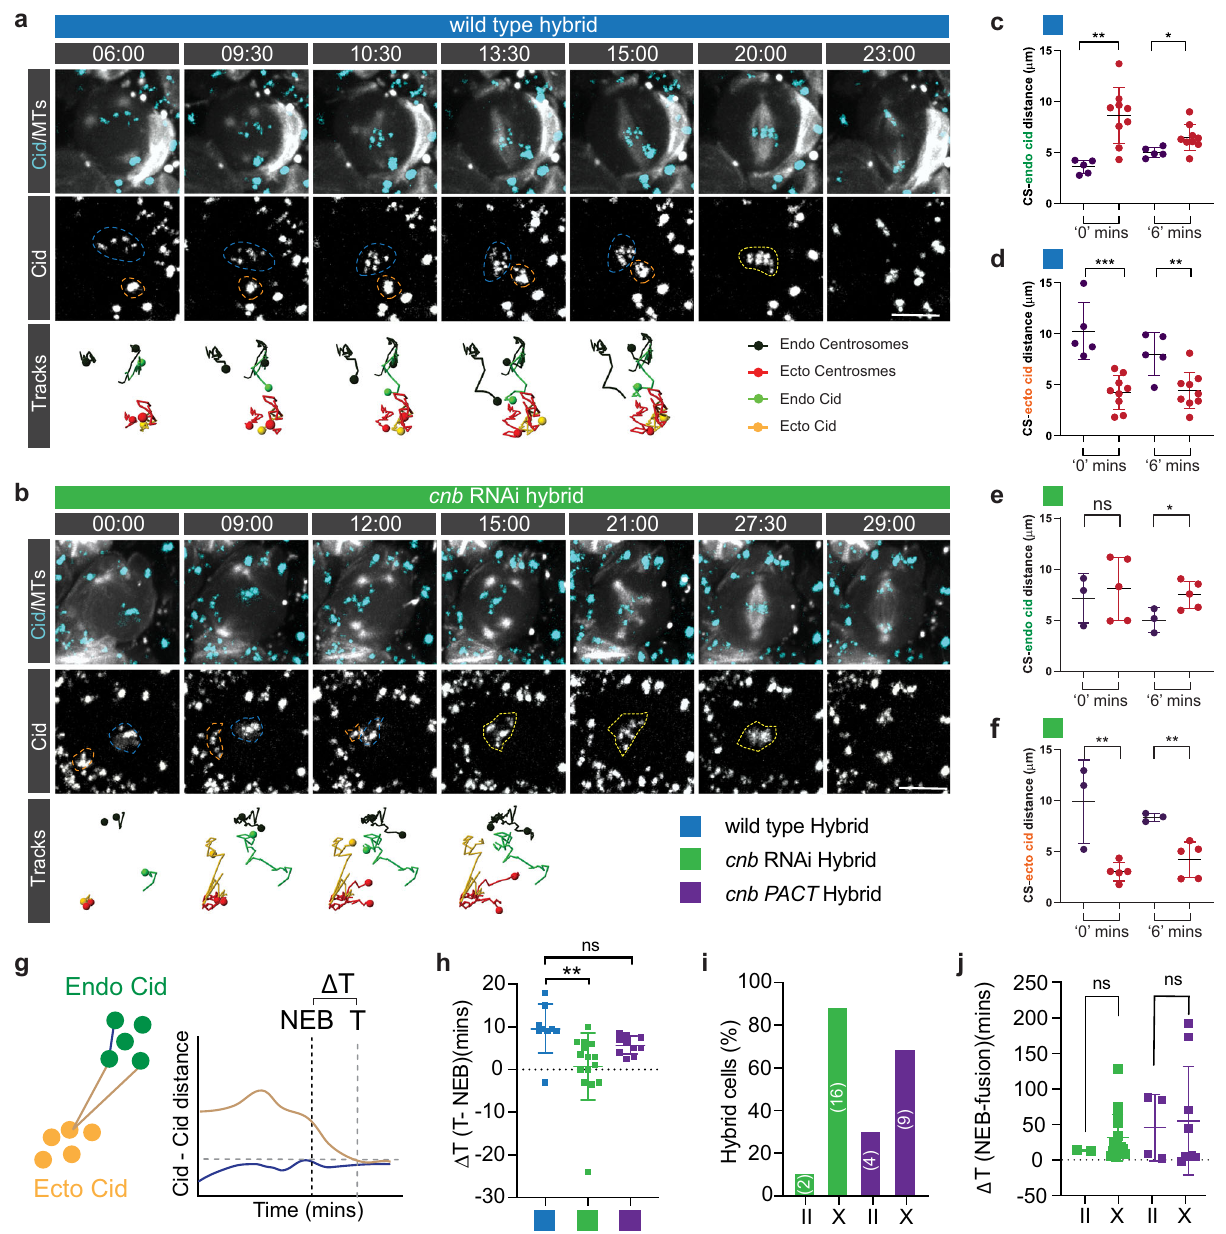
Fig. 5 Asymmetric microtubule dependent centrosome-chromatin attachments contribute to the separation of endogenous and ectopic chromosomes in hybrid cells. Representative third instar larval (a) wild type or (b) cnb RNAi hybrid cell, expressing EGFP::Cid (top row; cyan, bottom row; white) and the microtubule marker cherry::Jupiter (white; top row). Neuroblast-derived and GMC-derived Cid clusters are outlined with a blue and orange dashed line, respectively. Indistinguishable GMC and NB Cid clusters are highlighted with yellow dashed circles. Centrosome and Cid tracks are shown below the snapshots. Scatter plot showing the distance of endogenous Cid in relation to GMC- and NB-derived centrosomes (CS) for c wild type (blue square) and e cnb RNAi expressing hybrid cells (green square). Scatter plot showing the distance of ectopic Cid in relation to GMC- and NB-derived centrosomes (CS) for d wild type (blue square) and f cnb RNAi expressing hybrid cells (green square). g The distance of endogenous-to-ectopic Cid, or endogenous-to- endogenous Cid was measured and Delta T – the time difference between NEB and when Ecto-Endo Cid distance is the same as Endo-Endo Cid distance (T) - plotted for h wild type, cnb RNAi and cnb PACT . i Percentage of II vs X spindles in cnb RNAi and cnb PACT . j Scatter plot showing the time between fusion induction and NEB for cnb RNAi or cnb PACT hybrid cells containing ‘ II ’ and ‘ X ’ spindles. Error bars correspond to SDs. h , j Two-sided unpaired t-test. ns; no signi fi cance. * p < 0.05, ** p < 0.01, *** p < 0.001, **** p < 0.0001. Time in mins:secs. Scale bar is 10 μ